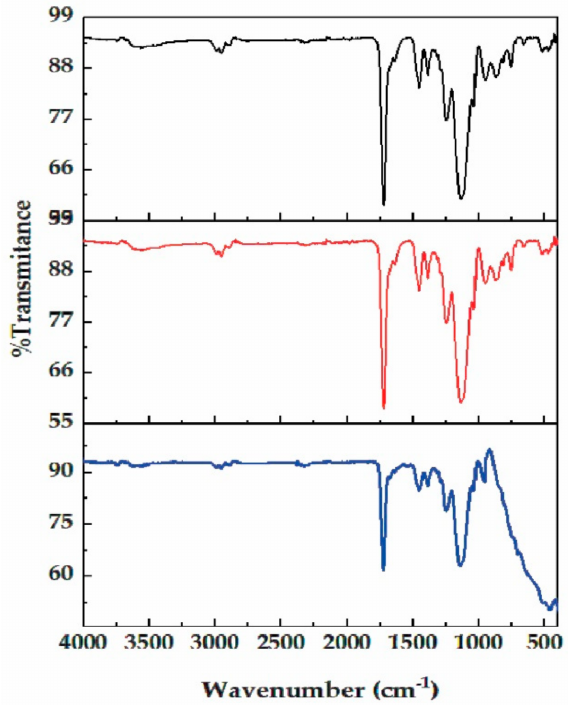
Figure 3. FT-IR spectra of the MIP, IIP, and NIIP (black, red, and blue lines,